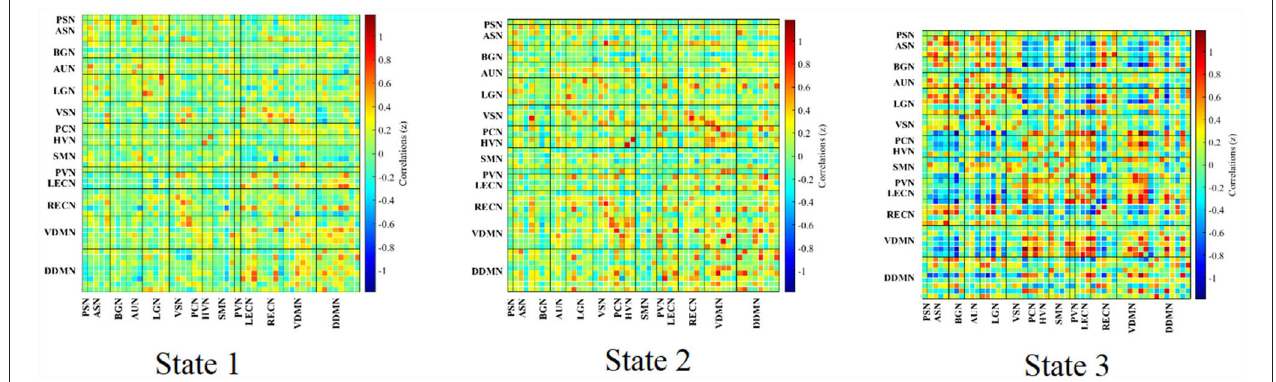
FIGURE 7 | Clustered states in dynamic FNC analysis averaged over the